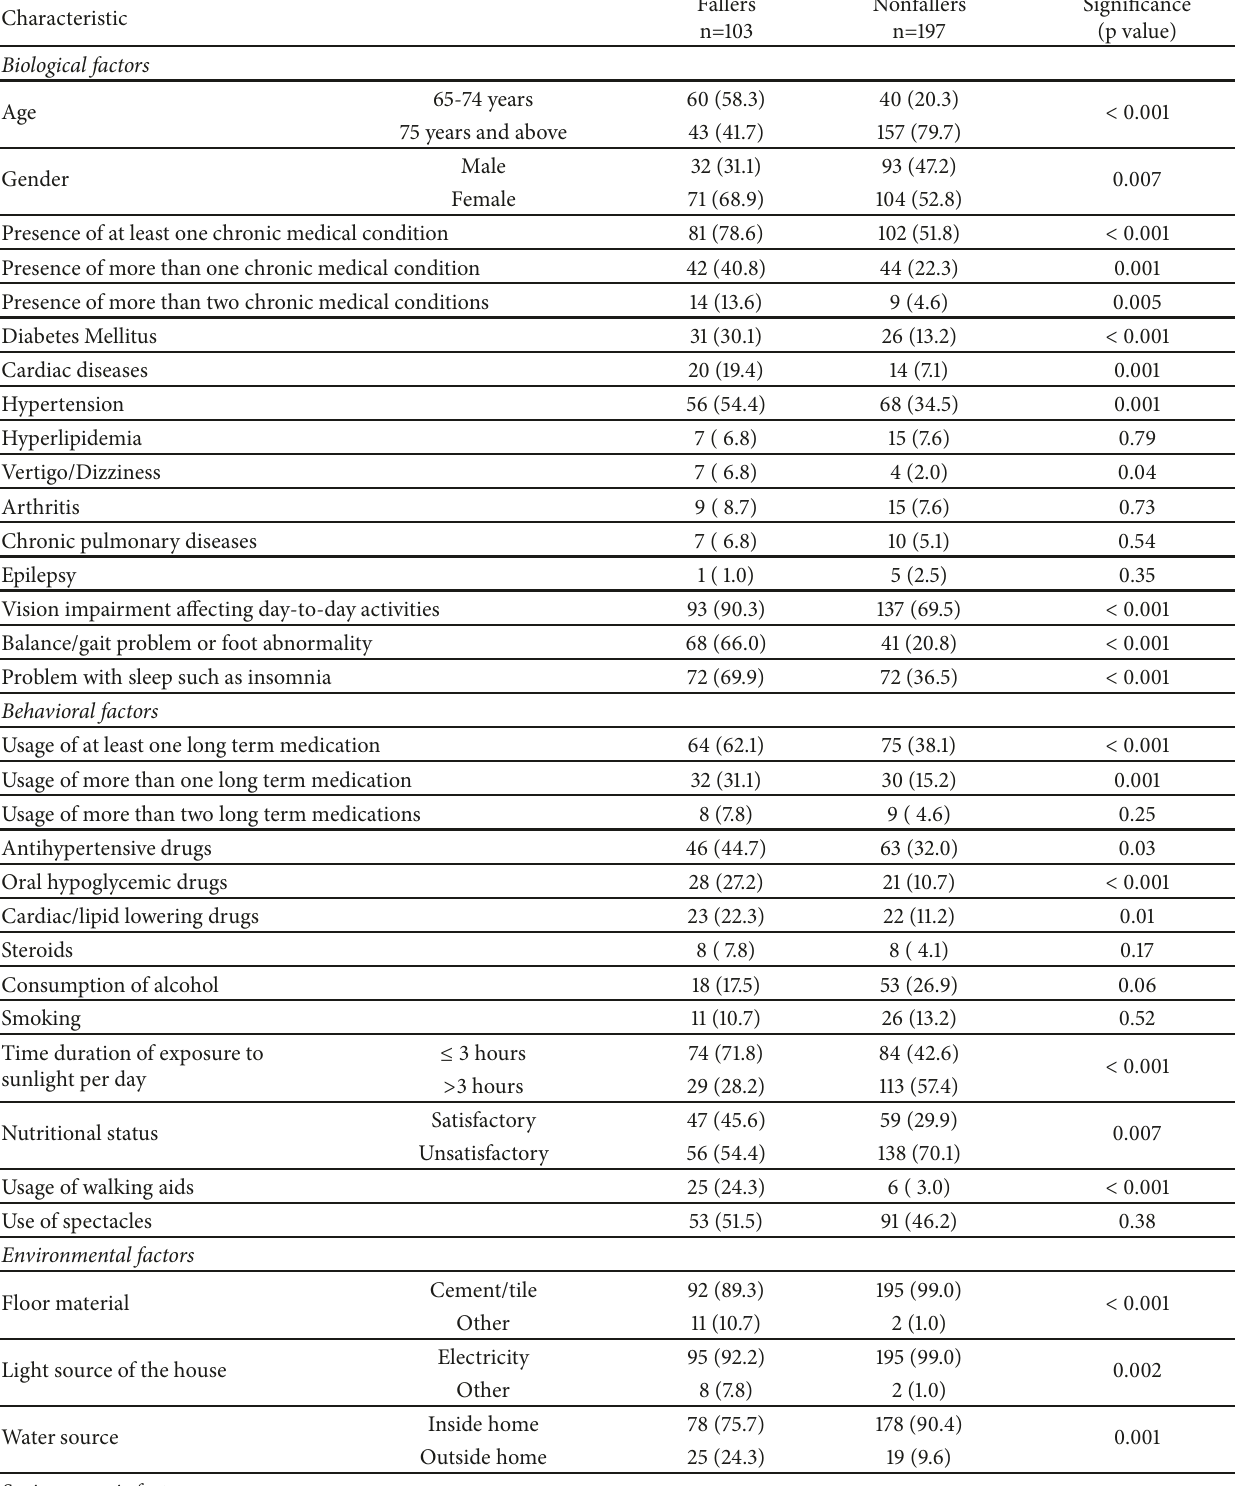
Table 3: Comparison of risk factors between fallers and nonfallers